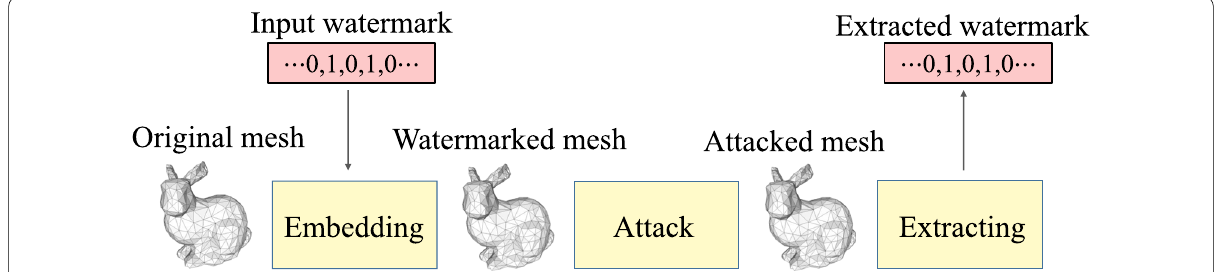
Fig. 1 3D mesh watermarking model. Actual watermarking procedure includes three processes: watermark embedding, attack and watermark extracting. Attack process represents the possible operations on the watermarked